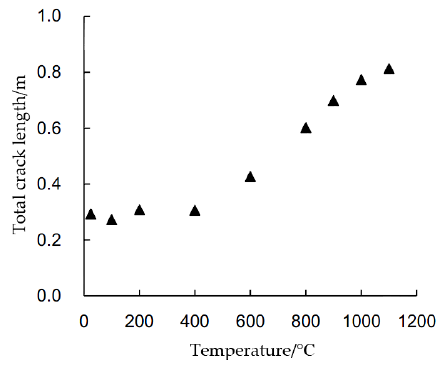
Figure 15. Total crack length of the specimens after loading varies with temperature.